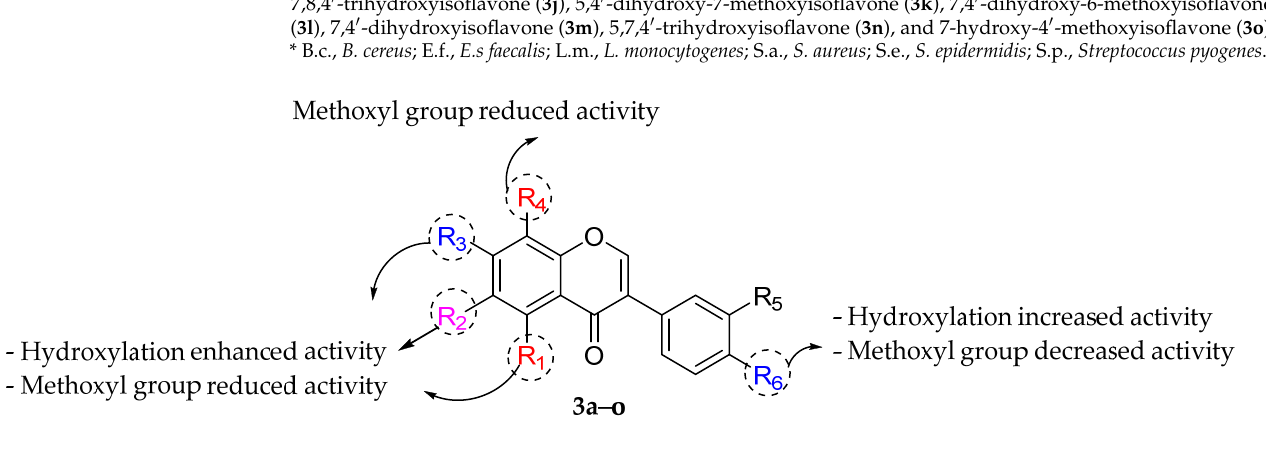
Figure 15. SAR of isoflavones as antibacterial agent [81].